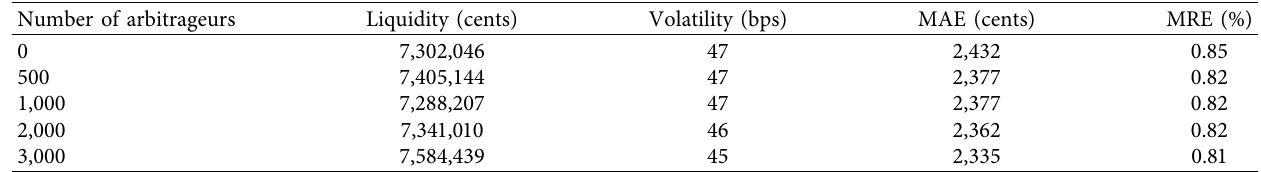
Table 11: Impact of arbitrageurs of the stock index futures market.